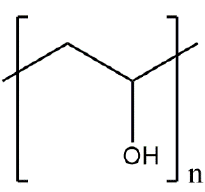
Figure 18. Schematic representation of the chemical structure of poli(vinyl alcohol) (PVA).